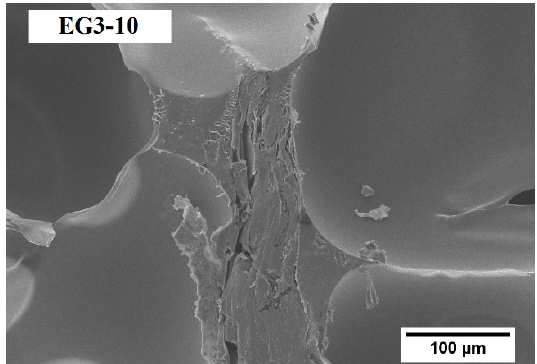
Figure 3. SEM micrograph of EG3-10 sample in the RPUF matrix.